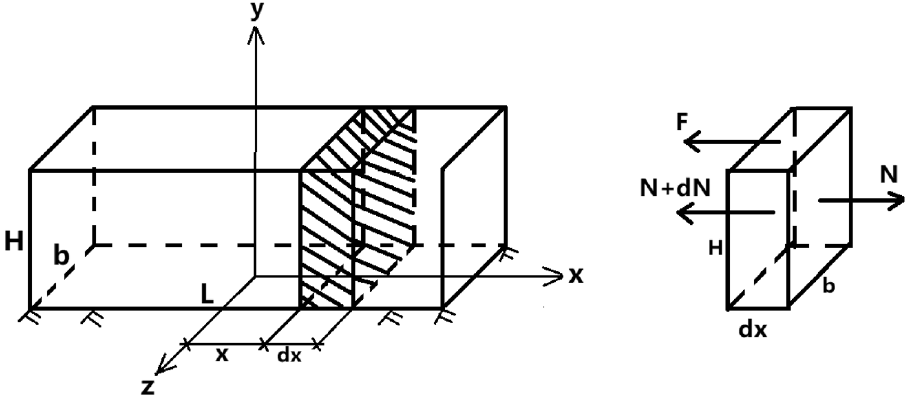
Fig. 1 Semi-rigid type base dry shrinkage stress